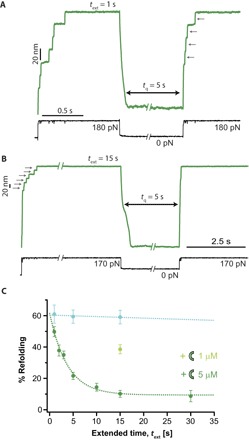
DnaJ binds to the unfolded and extended state of ubiquitin.(A) Changing the time of the initial pulse in the presence of DnaJ enables binding to the unfolded ubiquitin. After a short extended time text = 1 s, ubiquitin shows a high refolding efficiency, fingerprinted by a large number of 20-nm steps in the test pulse. (B) Upon increasing text = 15 s, the refolding efficiency is markedly decreased. (C) Evolution of the refolding efficiency as a function of text for a constant tq = 5 s. In the presence of 5 μM DnaJ, the folding efficiency decreases exponentially with the text with an associated rate k = 0.27 ± 0.05 s−1 (green symbols). The number of individual trajectories used was text = 1 s, n = 33; text = 2 s, n = 43; text = 3 s, n = 57; text = 5 s, n = 84; text = 10 s, n = 52; text = 15 s, n = 45; text = 30 s, n = 21. Decreasing the concentration of DnaJ down to 1 μM increases the refolding percentage for a constant text = 15 s (n = 63, light green symbol), demonstrating that DnaJ binding to ubiquitin is a concentration-dependent mechanism with an associated association constant, kon. In the absence of DnaJ, the refolding of ubiquitin is largely independent of text (blue symbols; text = 1 s, n = 26; text = 5 s, n = 33; text = 15 s, n = 17).